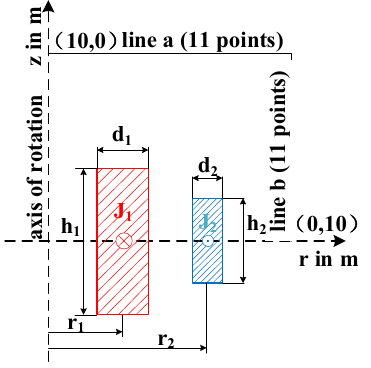
Figure 8. Configuration of a SMES device.